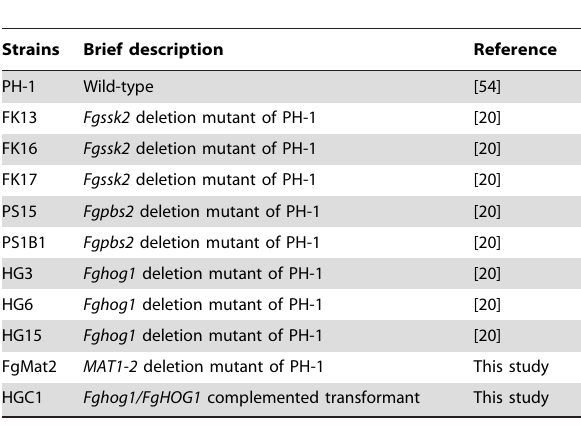
Table 1. Wild-type and mutant strains of Fusarium graminearum used in this